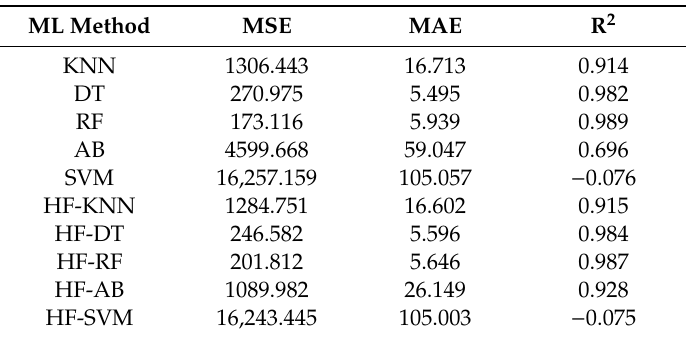
Table 9. Longitude regression results of testing data.